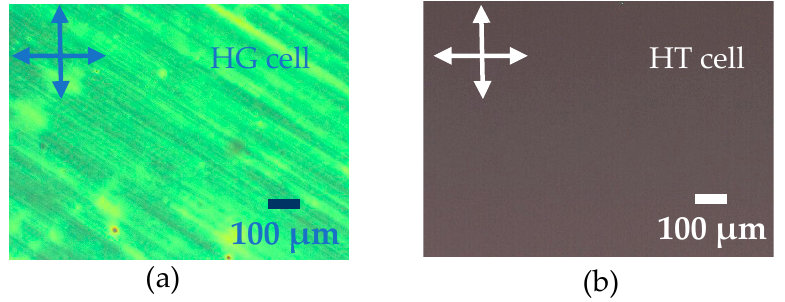
Figure 7. Textures of a purified LC mixture in ( a ) homogeneous and ( b ) homeotropic alignments. The micrographs are recorded by POM under cross-polarized condition at room temperature.